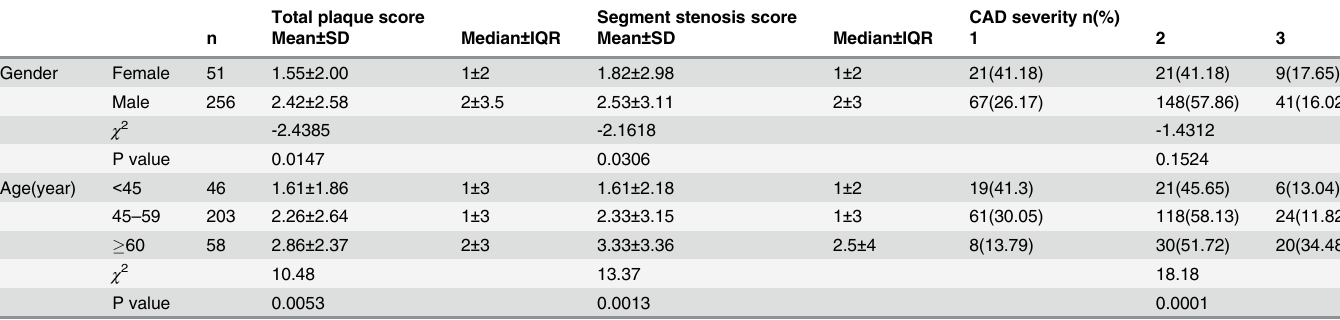
Table 2. The distribution of the scores in different gender and age